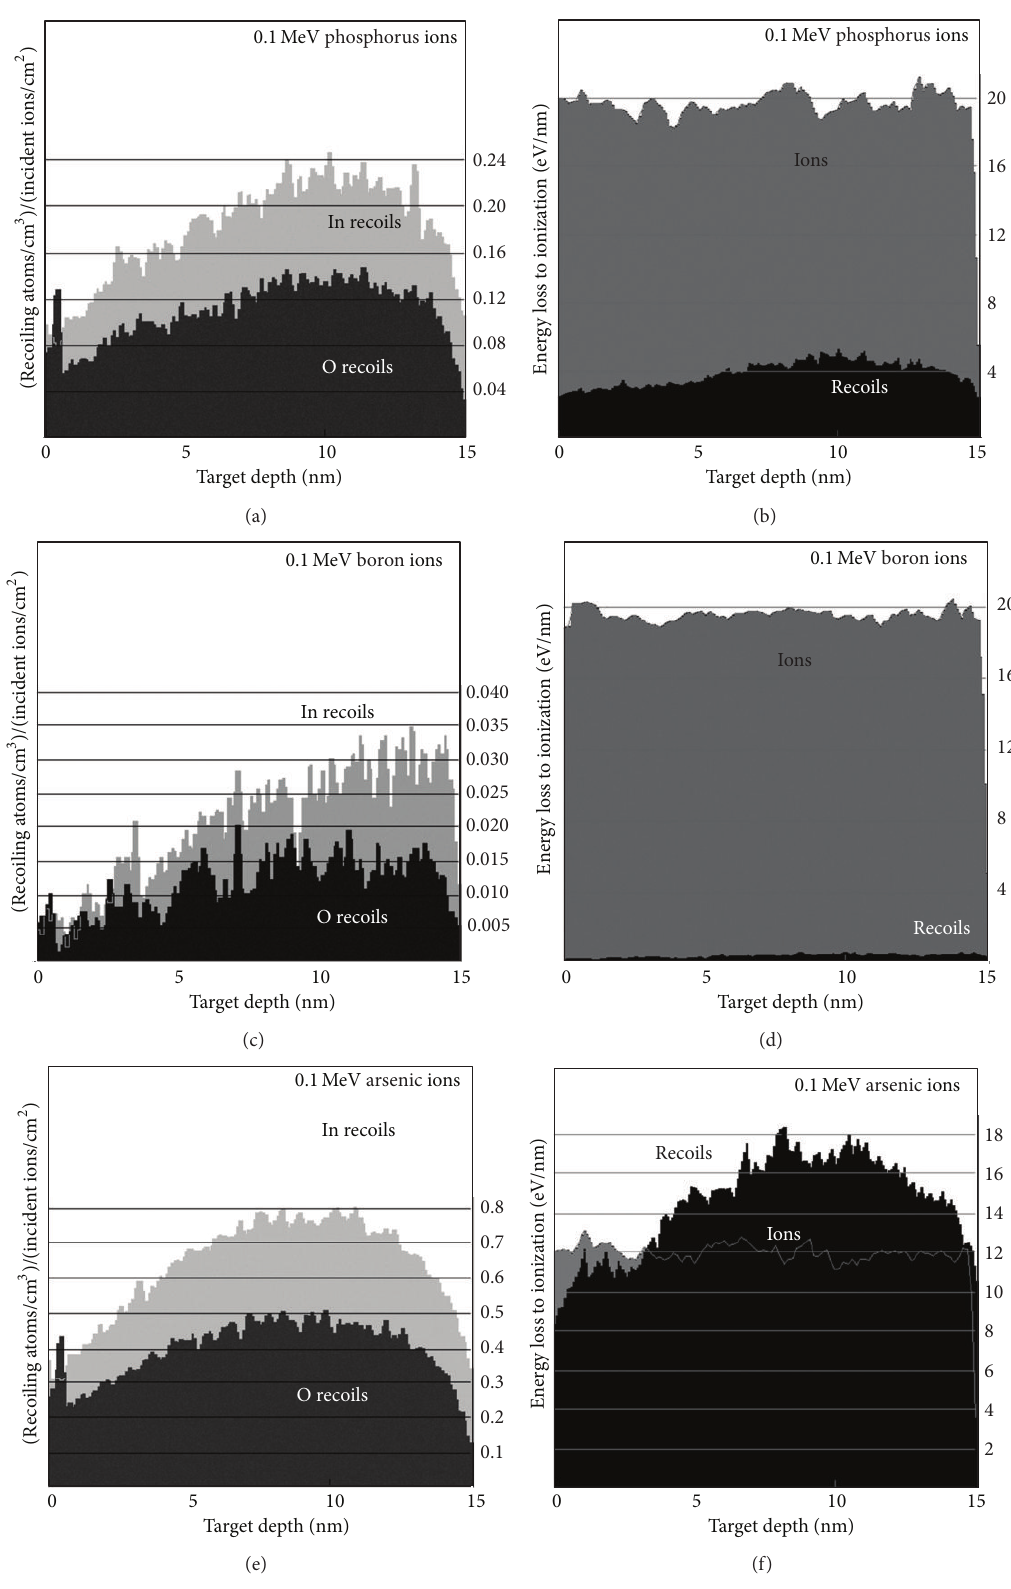
Figure 5: Distribution of the concentration of the recoils per unit ion fluence and ionization energy losses per unit depth in a 15nm thick InO 𝑥 film for a 0.1 MeV incident beam of 10 3 phosphorus ions (a and b), boron ions (c and d), and arsenic ions (e and